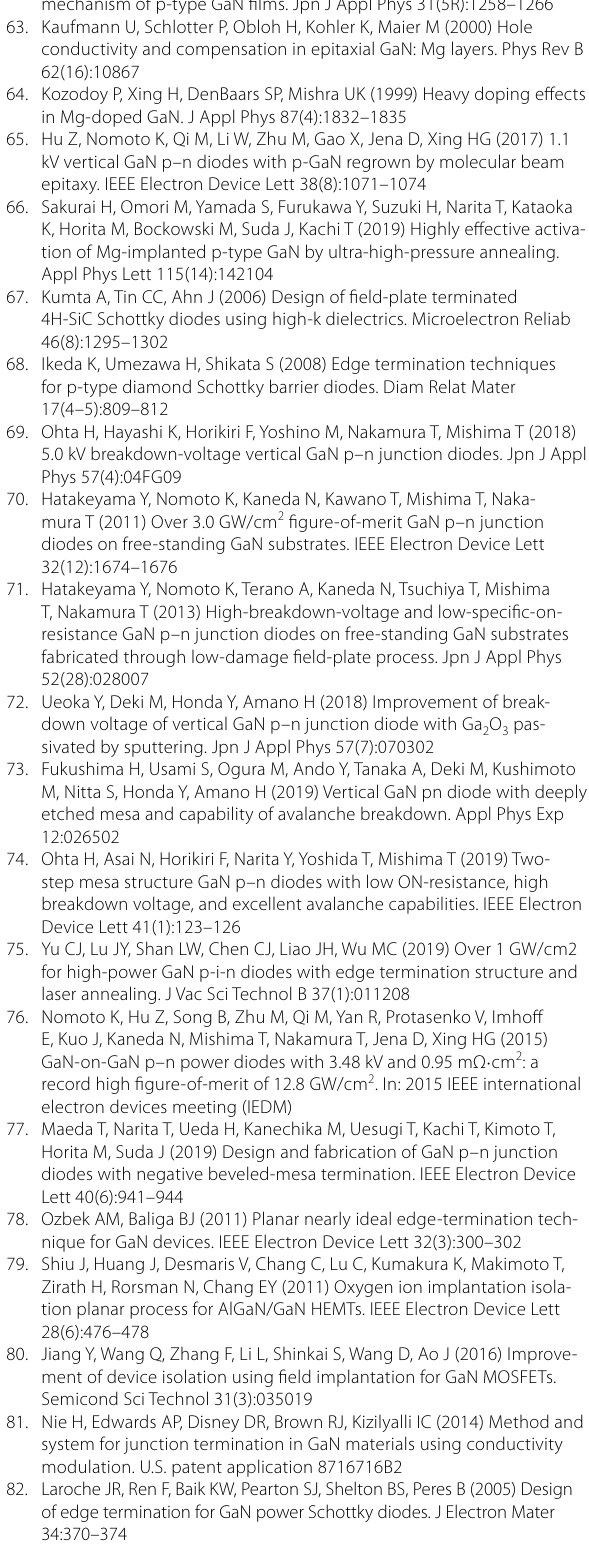
record high figure‑of‑merit of 12.8 GW/cm 2 . In: 2015 IEEE